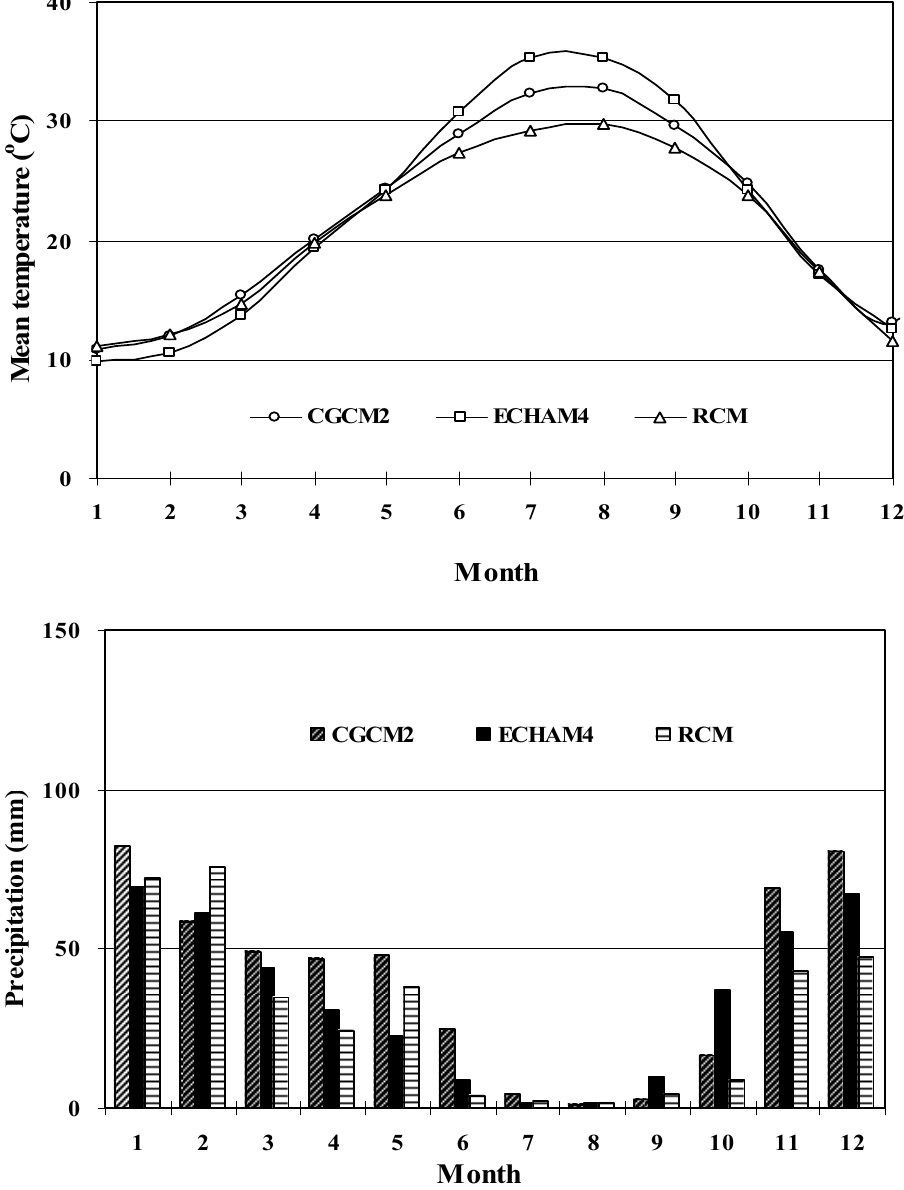
Figure 4. Comparison of monthly air temperature / precipitation created from the CGCM2, ECHAM4 and RCM models for a period of 10 years from